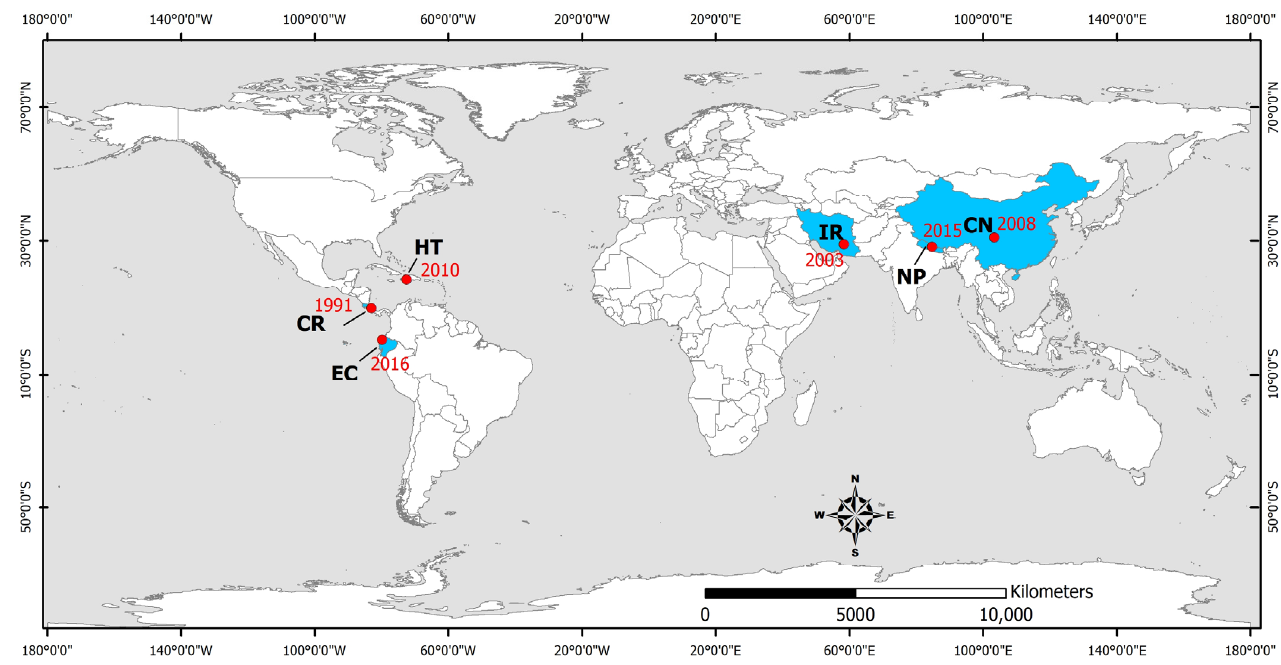
Figure 4. Countries affected by earthquake-triggered vector-borne infectious diseases. HT: Haiti, CR: Costa Rica, EC: Ecuador, IR: Iran, NP: Nepal, CN: China. The epicenters of the studied earthquakes are also illustrated (red dots), along with the occurrence year (red numbers). Table 4. Vector-borne infectious diseases transmitted during the post-earthquake period in earth- quake-affected areas.